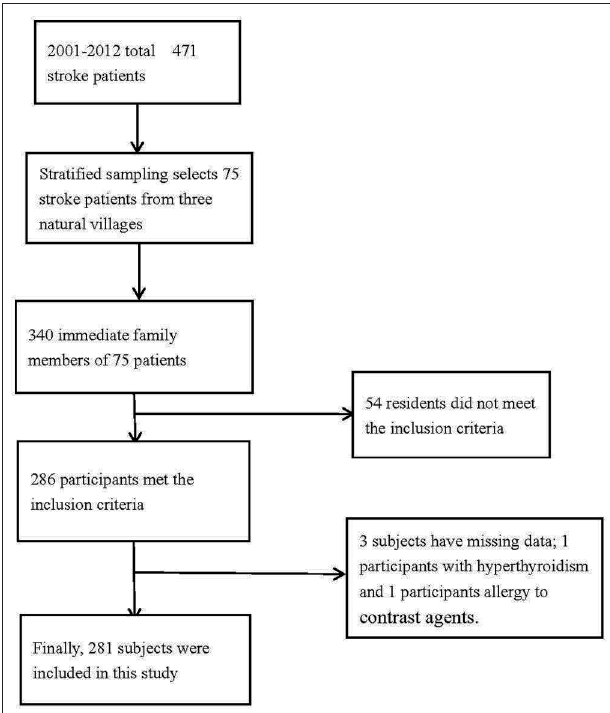
FIGURE 1 | Flow chart of participants’ selection.